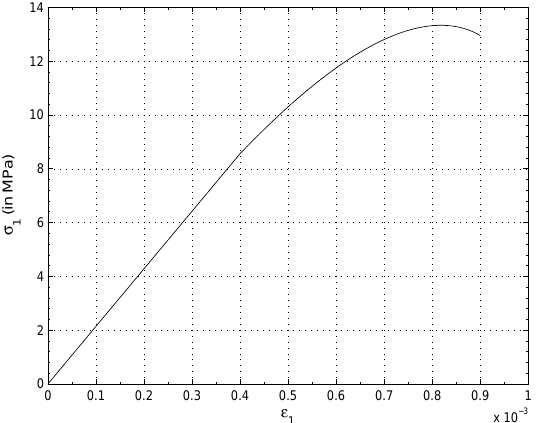
Figure 2. Uniaxial tension. Uniaxial stress-strain curve.